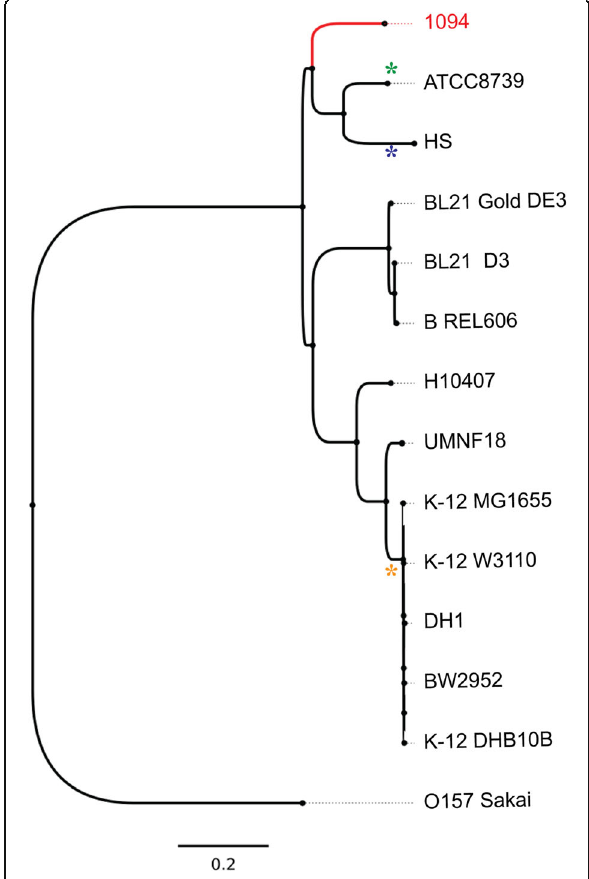
Fig. 2 Phylogenomic comparison of E. coli strains from phylogenetic group A. The tree was inferred using Parsnp, a fast core-genome multi-aligner. Color-coded stars represent relevant genetic events related with the loss of cellulose production: orange, premature stop codon in bcsQ ; purple, deletion of a large bcs region; green, premature stop codon in bcsE